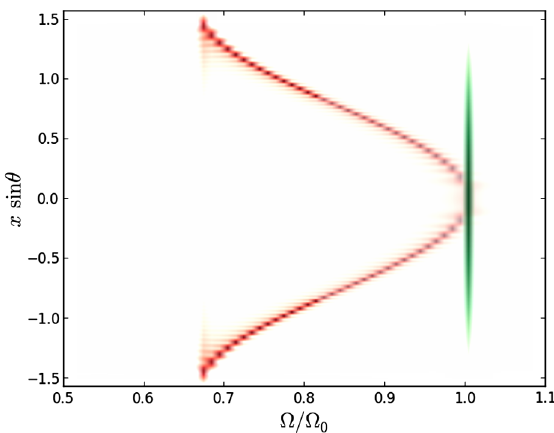
FIG. 2. Electron beam mode frequency as a function of the x coordinate for the elliptic (red) and the harmonic (green) electron